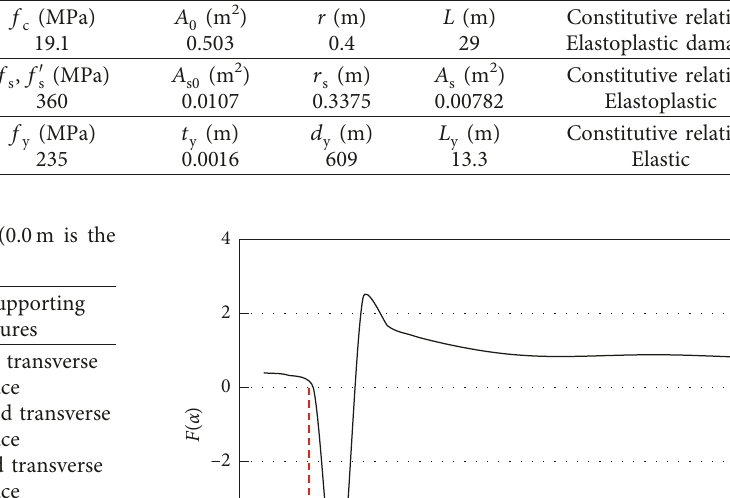
Table 2: Parameters of the supporting structure system.